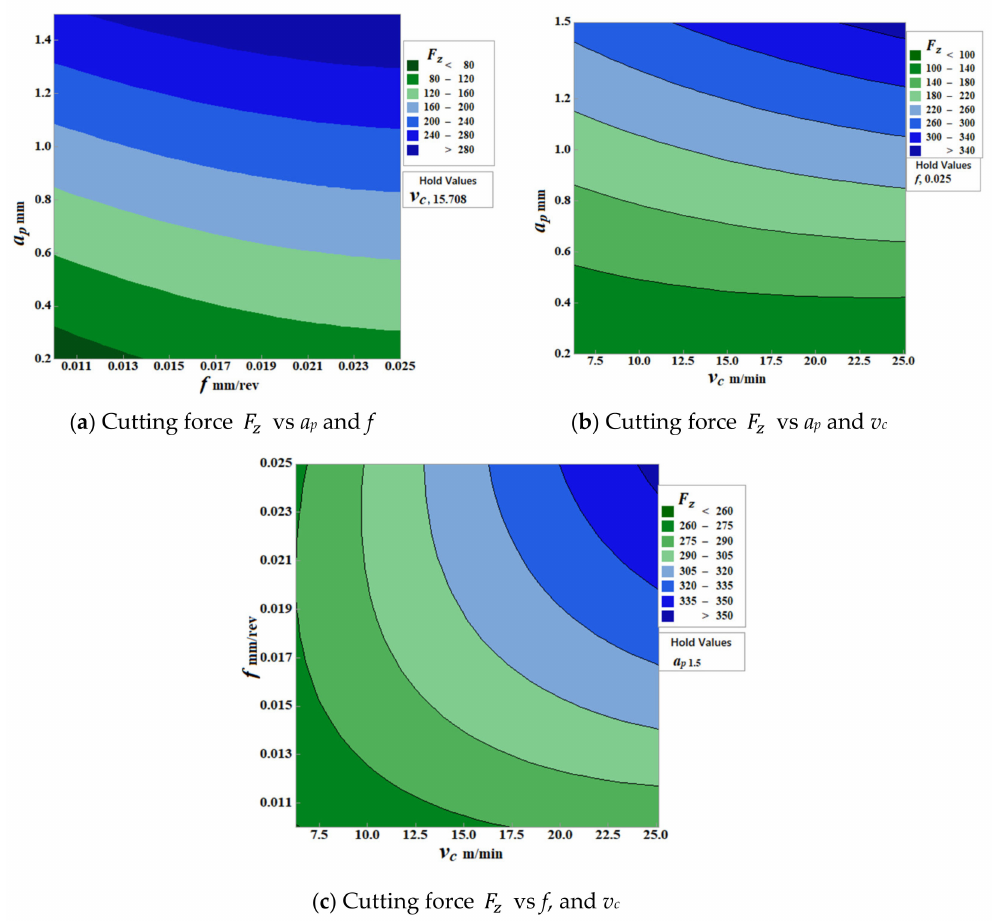
Figure 7. ( a – c ) Cutting force F z vs. v c , f , a p